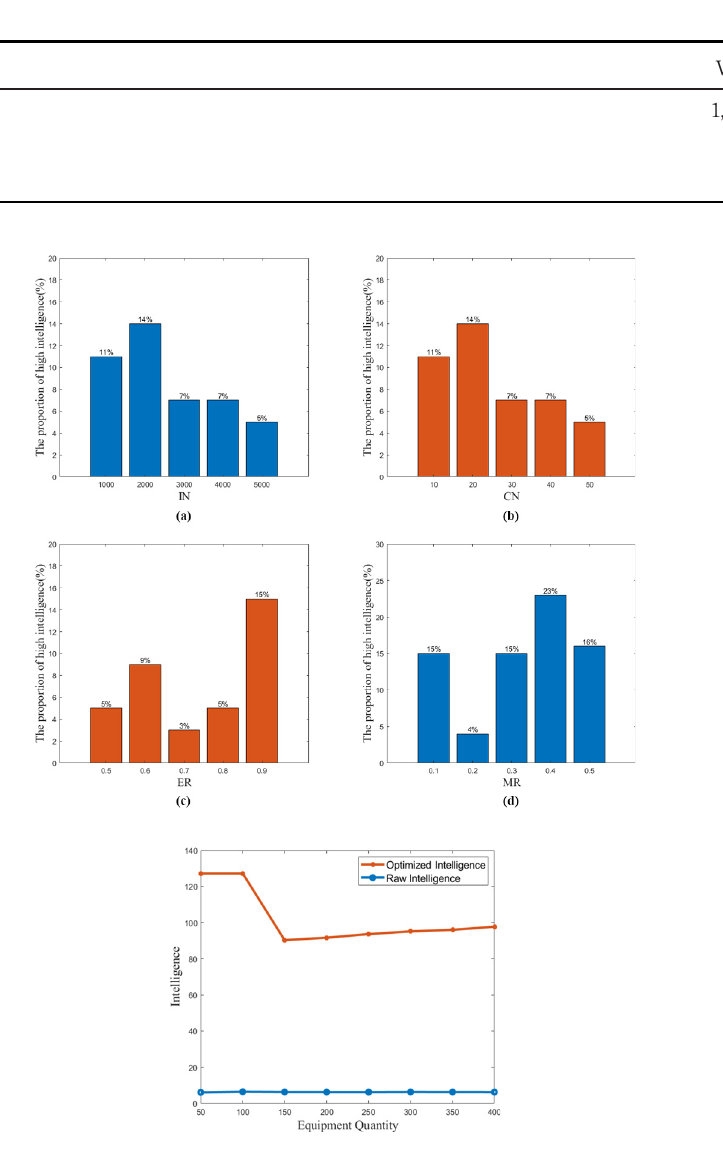
Figure 5. Comparison